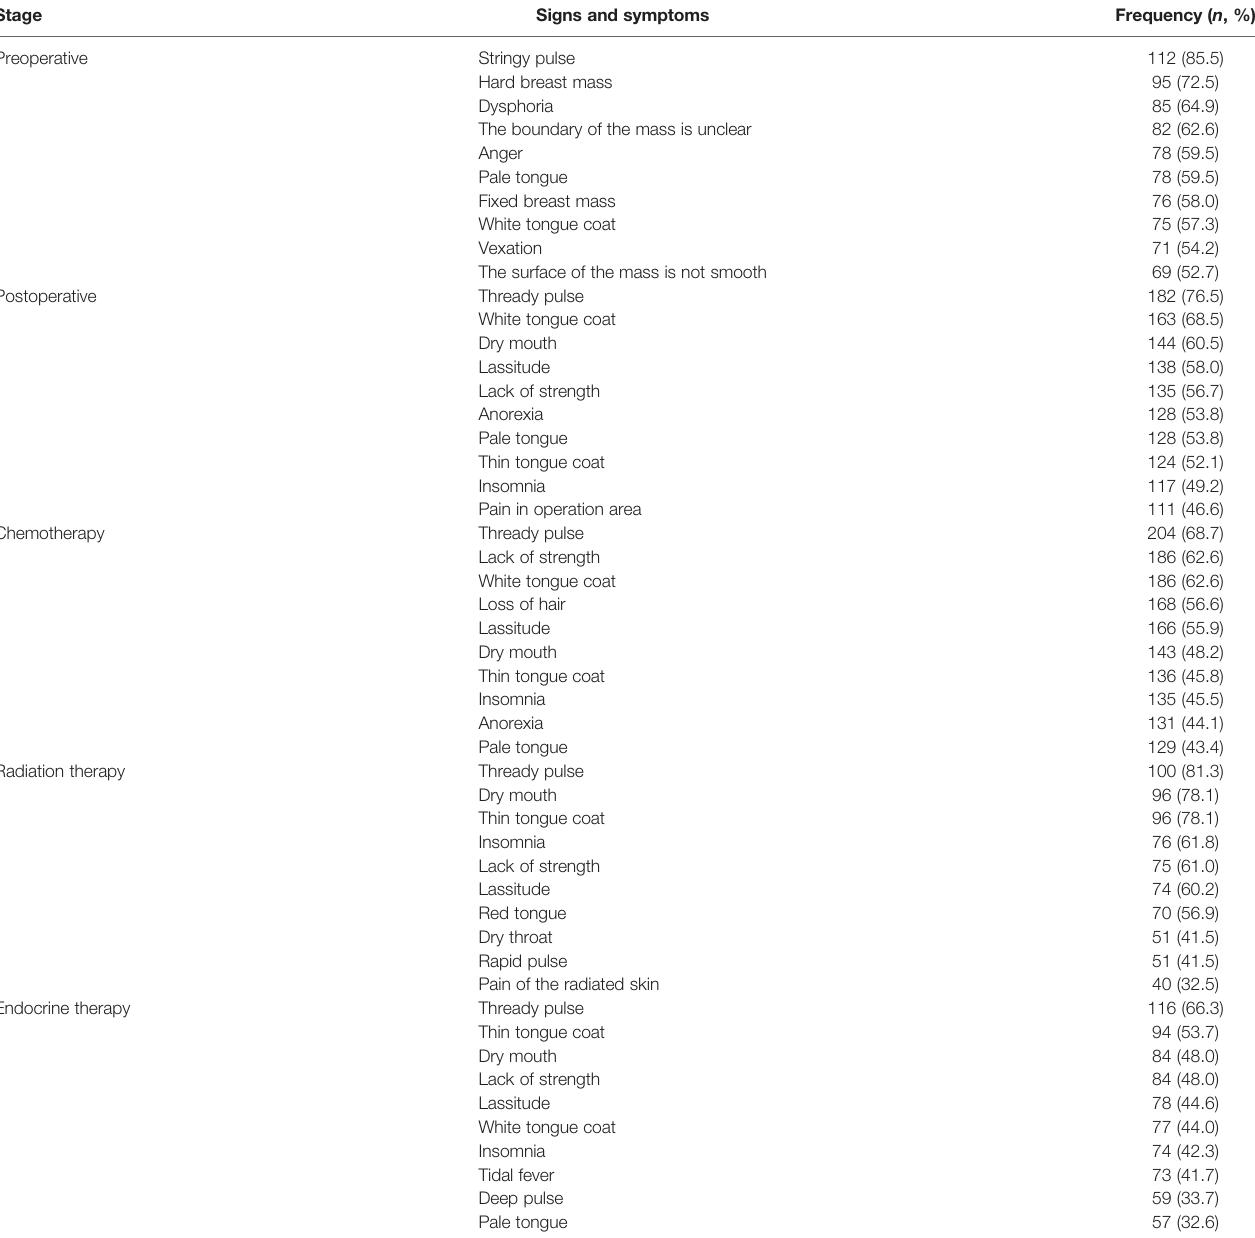
TABLE 3 | Ten most frequently reported Chinese medicine signs and symptoms for each treatment